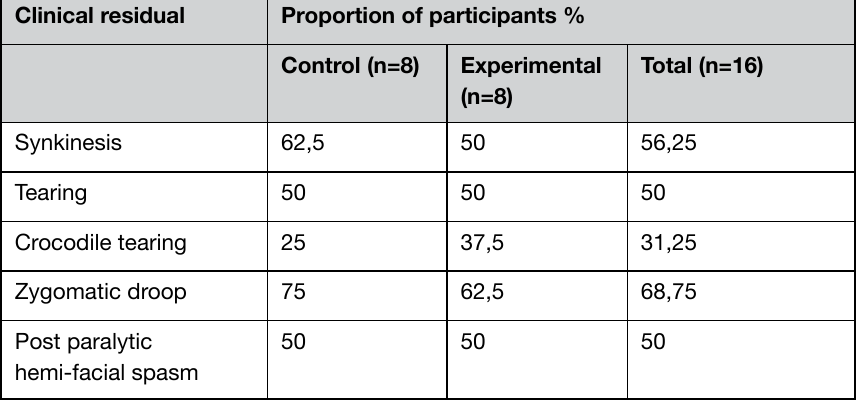
Table 5: Prevalence of common clinical residuals in the sample on discharge from the study.